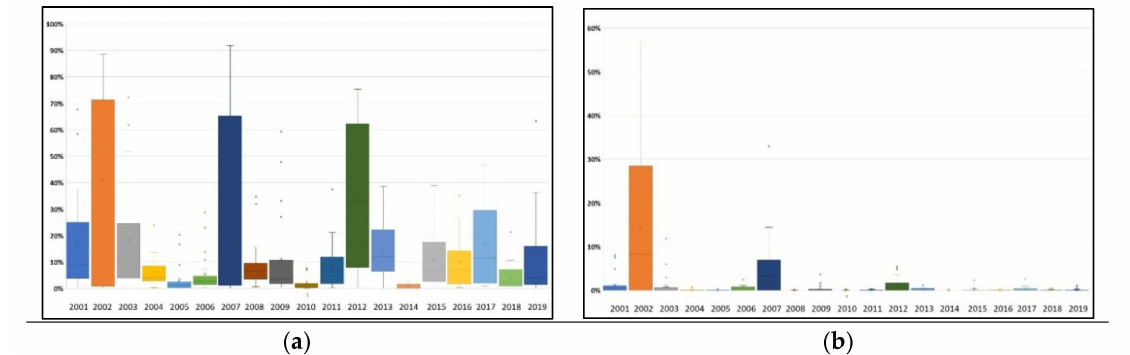
Figure 9. Box-plot type diagram of agriculture areas a ff ected: ( a ) by drought with di ff erent intensities; ( b ) by extreme drought, between 2001 and 2019 in Oltenia Plain. The number of samples for 2001 is 21 and for the other years the number of samples it is 23.